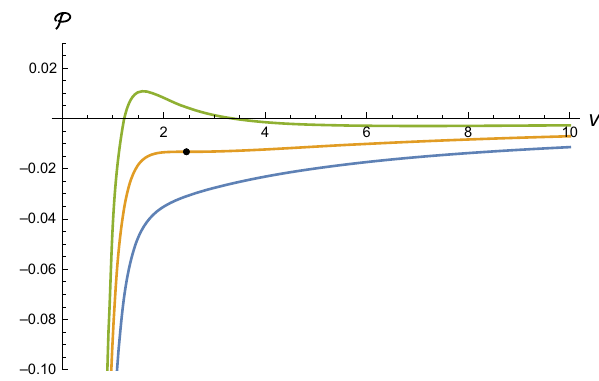
Fig. 8 P – v diagram of the RN-dS black hole in D = 4 dimensions. We set q = 1. The temperatures of the lines from top to bottom are T = 1 . 5 T c , T c , and 0 . 5 T c respectively. The black point is the critical